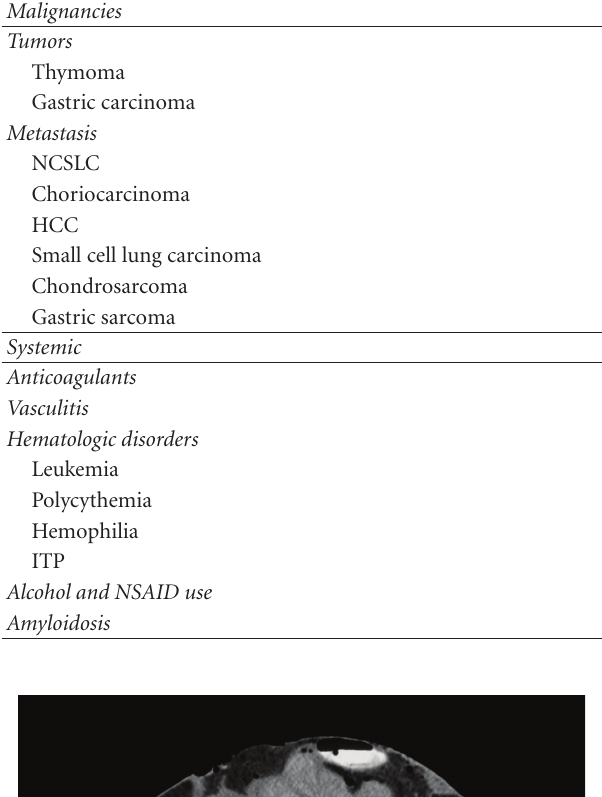
Table 1: Reported causes of retroperitoneal bleeding (Medline